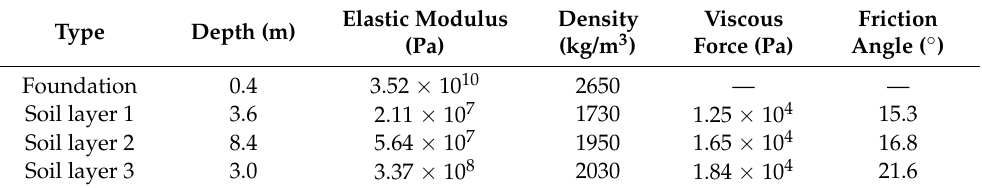
Table 3. The material parameters of the foundation and soil used in the test.